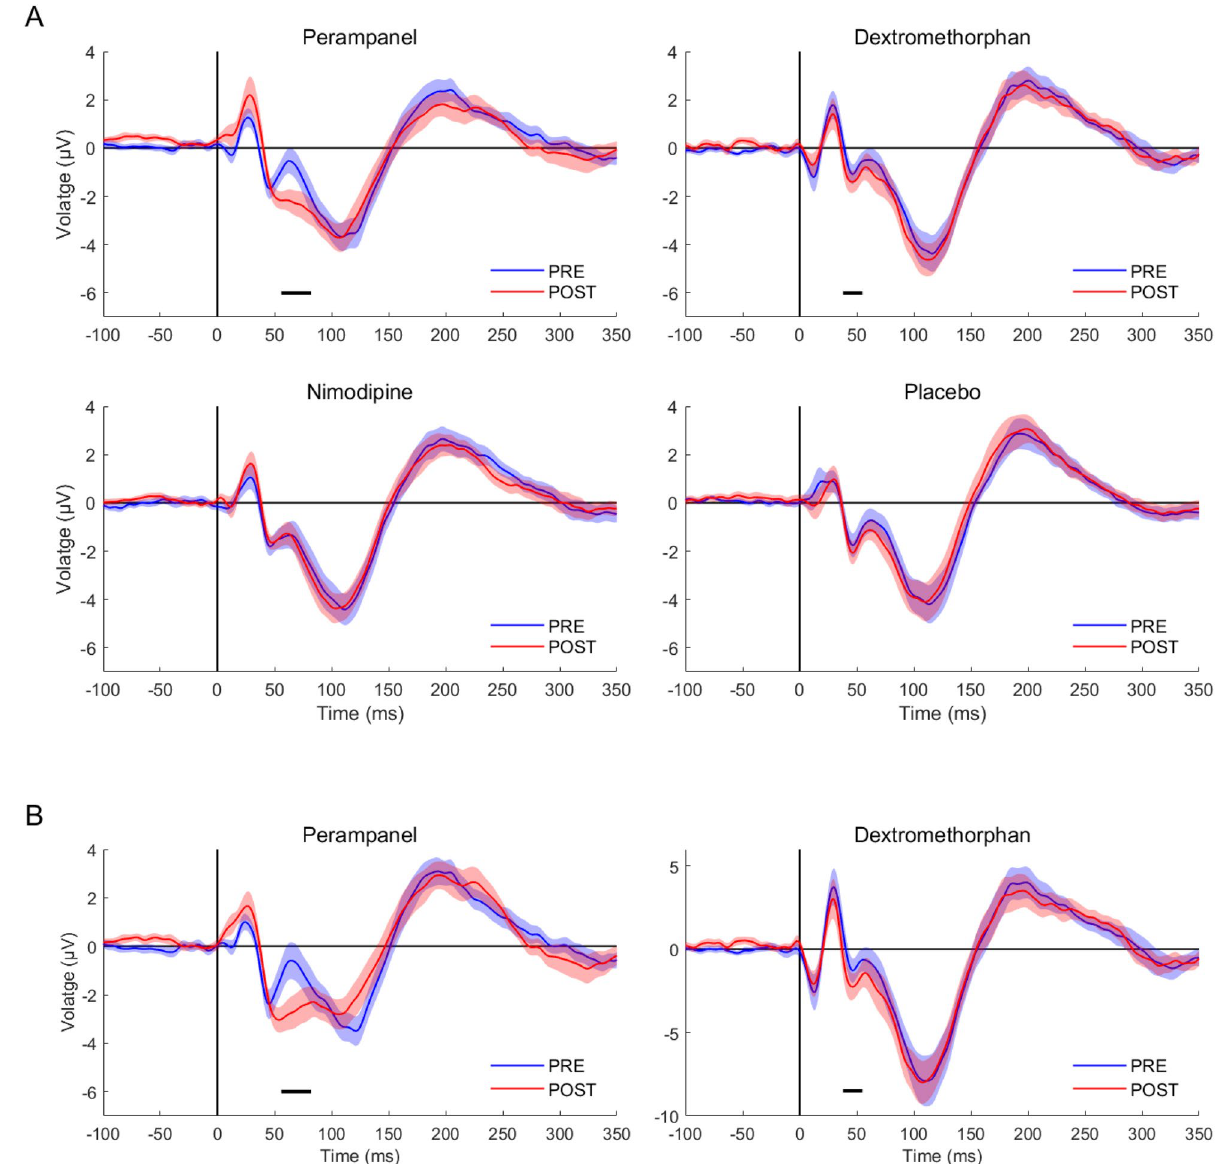
Figure 2. Group average of TMS-evoked EEG potentials (TEPs) pre- and post-drug intake. ( A ) Each panel shows the average TEP time course across subjects and all EEG channels of pre-drug (blue curve) vs. post- drug measurements (red curve) for the four drug conditions. Shades represent ± 1 SEM. Significant differences between the pre- and post-drug measurements are indicated with horizontal black bars. ( B ) To better elucidate the drug-induced changes of TEP components shown in ( A ), the same average TEP time courses are displayed for significant channels only (cf. Fig. 3). Shades represent ± 1 SEM. Figure generated with MATLAB R2016a (https:// www. mathw orks.